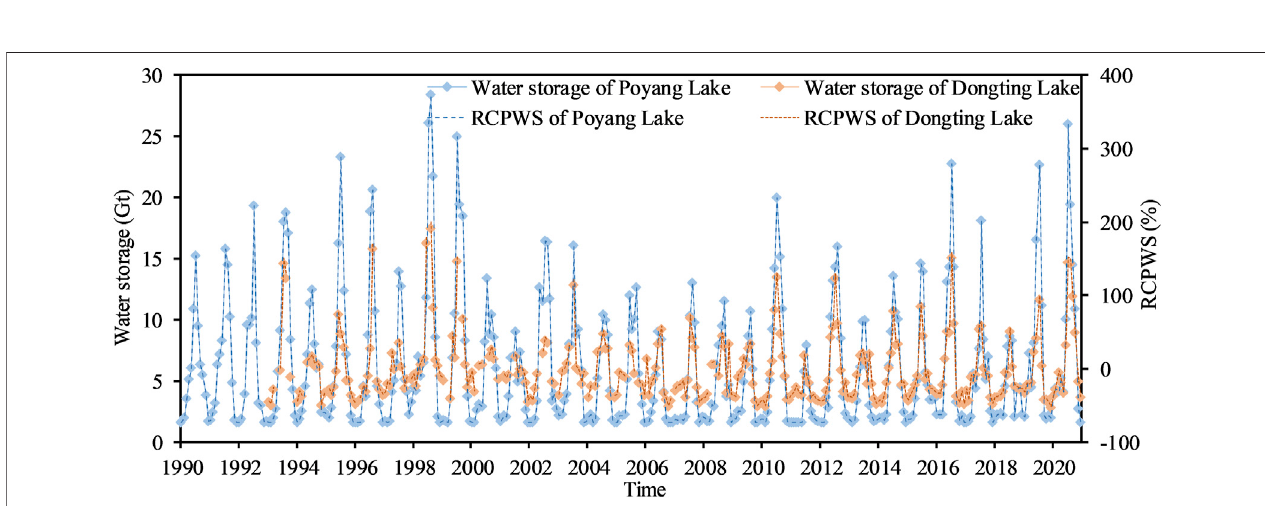
FIGURE 5 | Time series of the water storage and the relative change percentage of water storage (RCPWS) for Poyang and Dongting Lakes during 1990 – 2020.